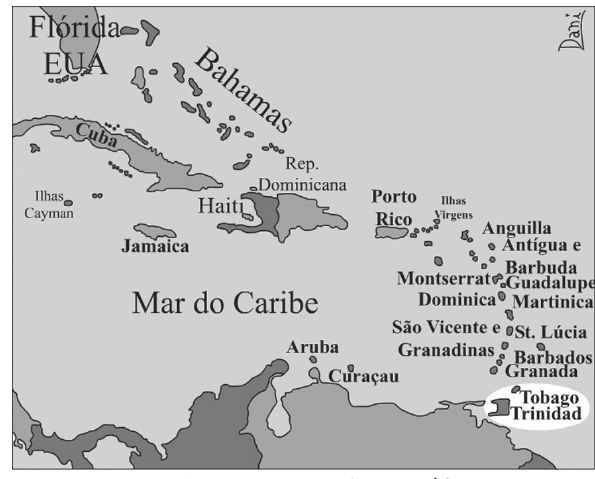
Fig. 1 - Mapa detalhando a localização geográfica de Trinidad e